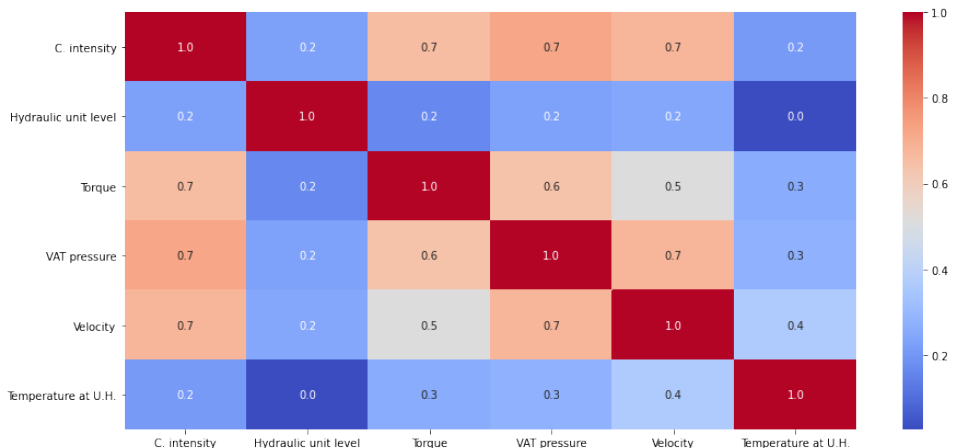
Figure 7. Correlation matrix, showing the correlation between all variables.